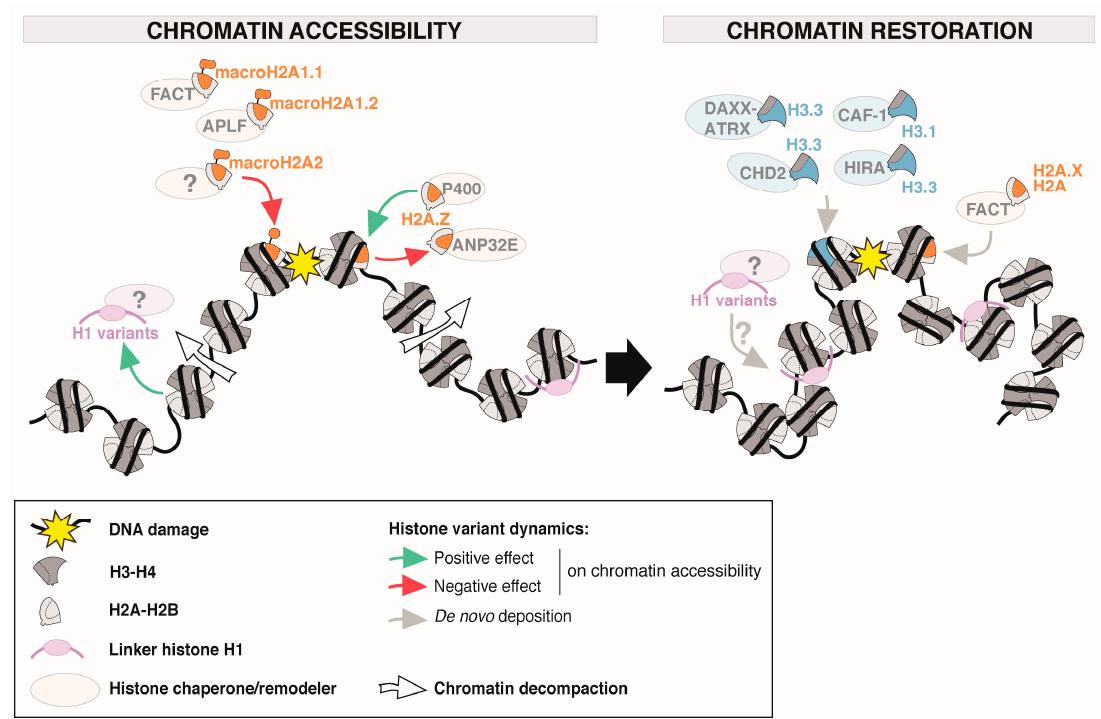
Figure 2. Histone variant roles in damaged chromatin accessibility and restoration. Following DNA damage (yellow star), chromatin accessibility is increased through transient decompaction. The deposition and eviction of specific histone variants in the damaged area positively (green arrows) or negatively (red arrows) contribute to chromatin accessibility. The subsequent restoration of chromatin architecture entails the de novo deposition of histone variants (grey arrows). When known, histone chaperones and remodelers involved in these transactions are indicated. Note that the distinction between histone variant roles in chromatin accessibility and restoration is not that strict: some newly deposited histones also increase chromatin accessibility to repair factors and some histone variants that a ff ect chromatin compaction may persist in chromatin thus contributing to chromatin restoration after damage repair. For simplicity, the responses to di ff erent types of DNA lesions are gathered on the same